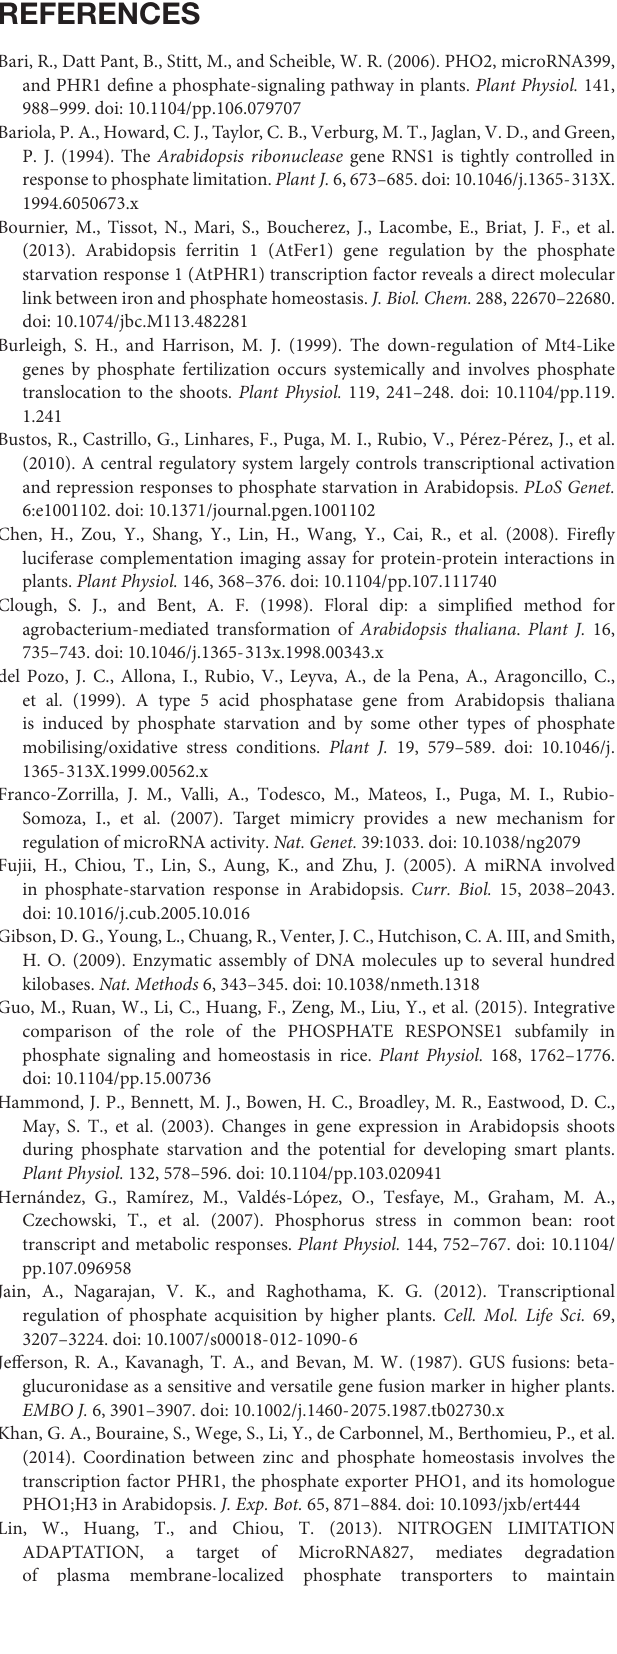
Frontiers in Plant Science |